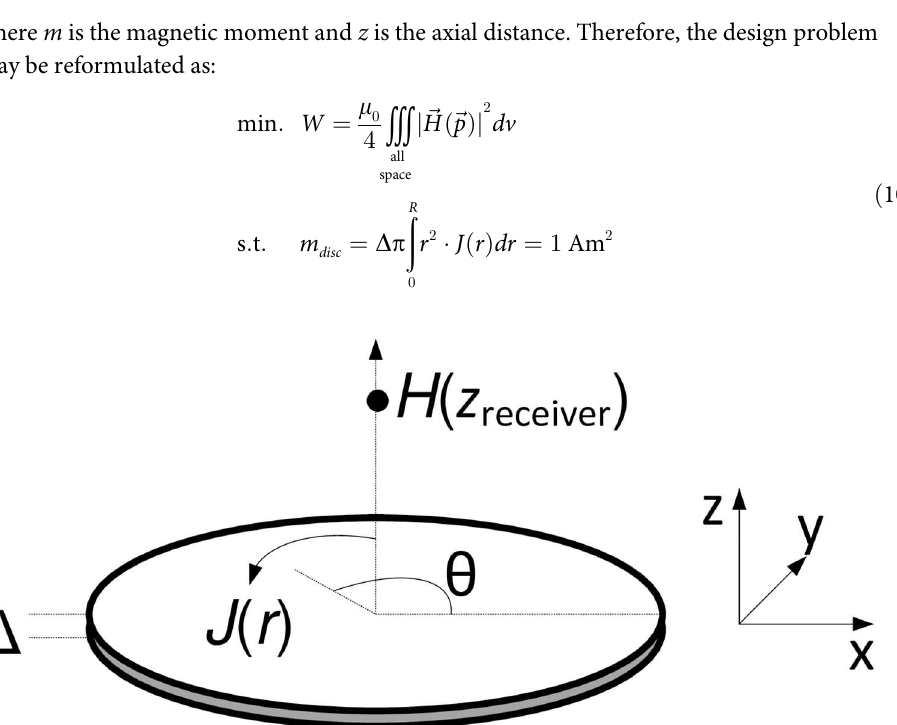
Fig 2. A flat disc with symmetrical current distribution J ( r